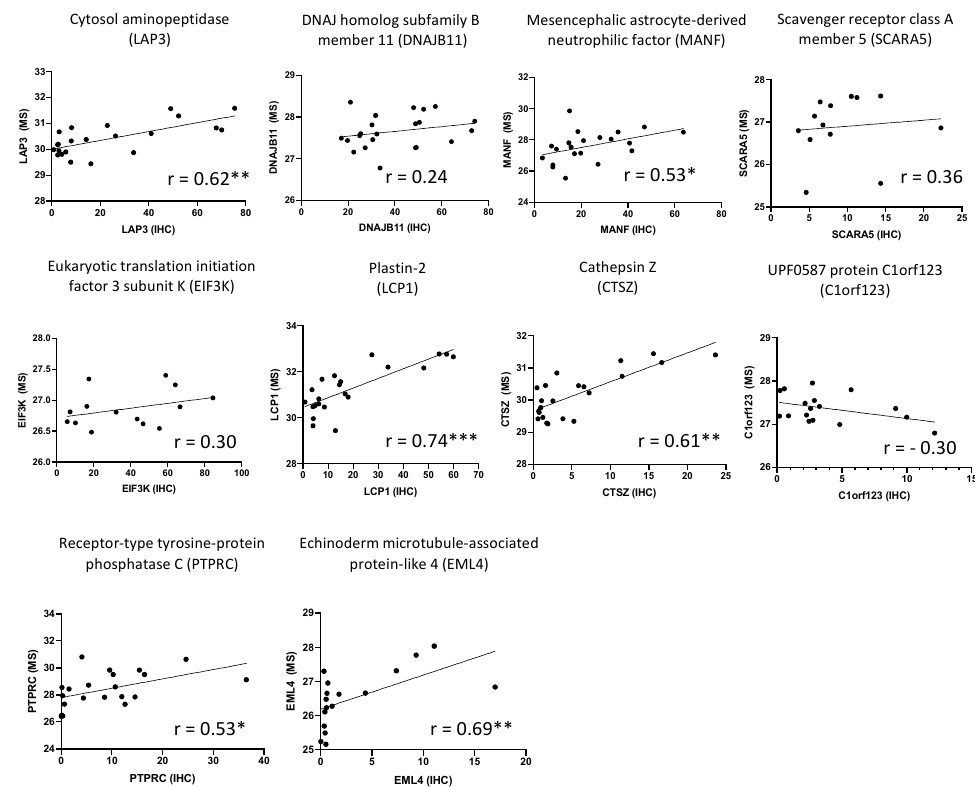
Figure 3. Correlation between mass spectrometry (MS) and immunohistochemistry (IHC) quantification of the 10 highlighted proteins in synovial membrane from OA, CPPA and RA patients. Protein expression levels (Log2 (LFQ)) obtained by mass spectrometry were correlated to the percentage of positive cells obtained by IHC using the non-parametric Spearman test: * P < 0.05, ** P < 0.01 and *** P < 0.001.